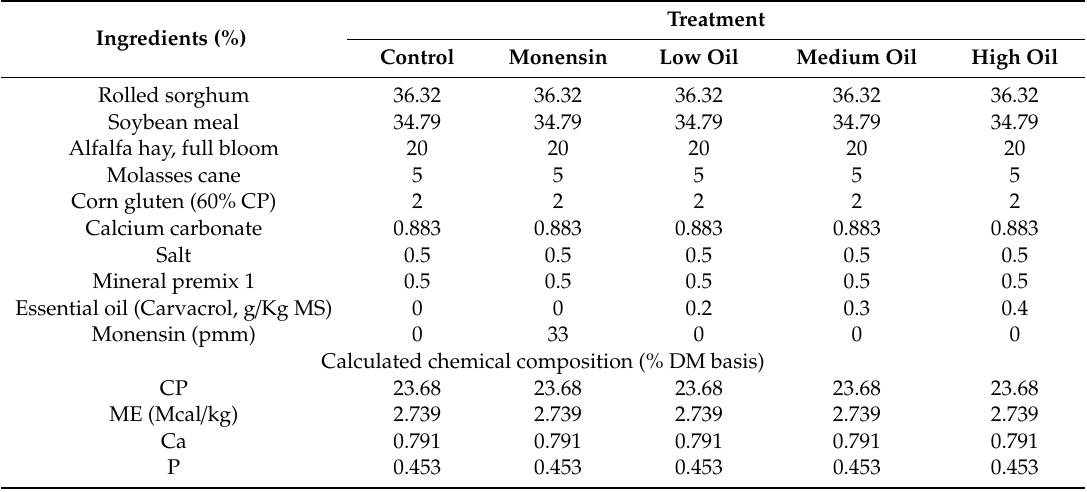
Table 3. Ingredients and chemical composition (DM basis) of diets of finishing hair lambs supplemented with